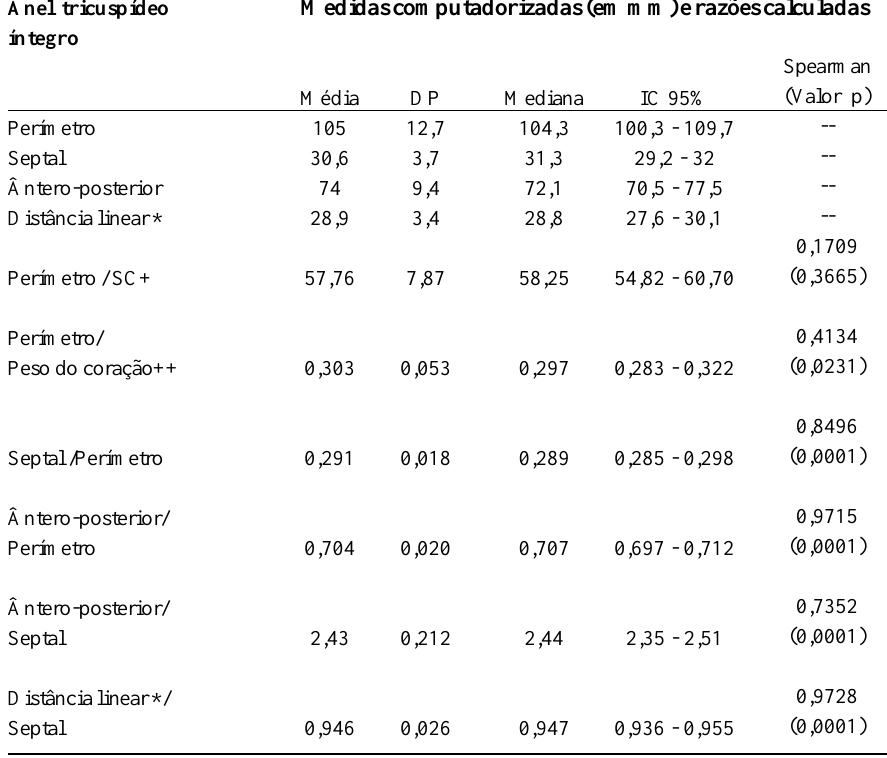
Tabela 1. Medidas e razões calculadas com anel tricuspídeo